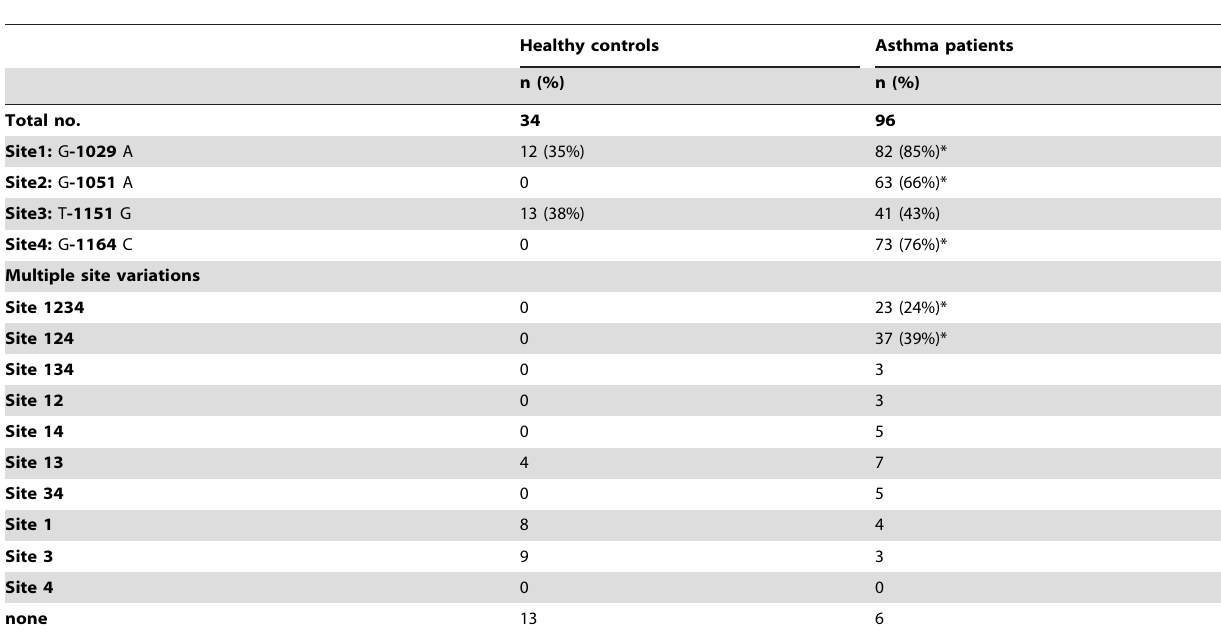
Table 3. Genotype and site variation frequencies in 5 9 flanking region of integrin b 4 gene.